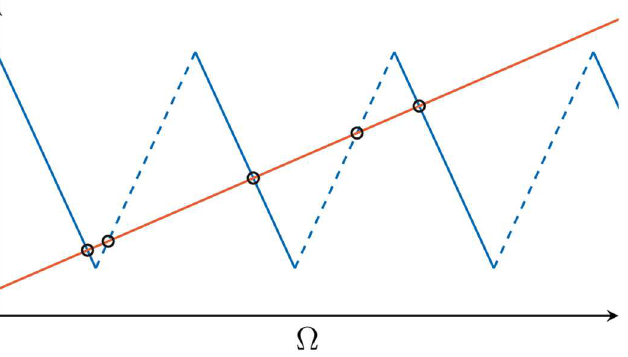
Fig 5. Global frequencies Ω for triangular coupling functions. Graphical representation of the lhs (red) and rhs (blue) of Eq (10) as a function of Ω . In this example,we find 5 coexisting solutionsfor the chosen τ -value,indicatedby